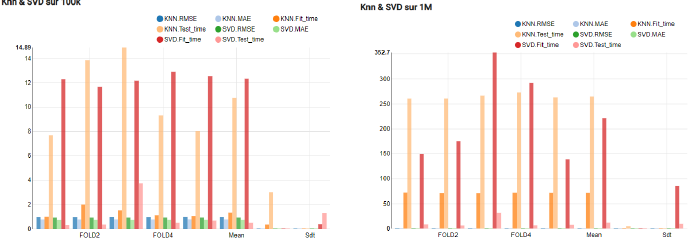
Fig. 2. Evaluation of RMSE, MAE on 100k and on 1M of the two algorithms KNN and SVD